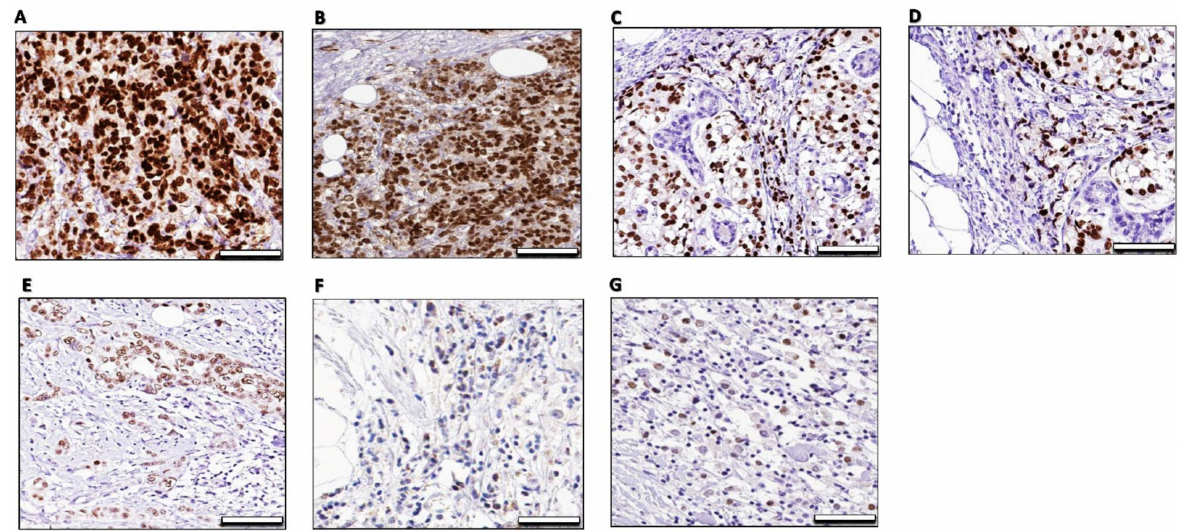
Figure 9. Immunohistochemical analysis of ER- α imunostaining of xenograft tumors the mammary gland fibromuscular stroma consecutive sections in different mice groups. The xenografted tumors were harvested and immunostained with the anti-ER α antibody. ( A )—MCF-7 xenograft: A photomicrograph of a section in the mammary gland of the control group showing a strong ER α -positive nuclear and/or cytoplasmic immunoreaction in the form of a brown color in the cells of the fibromuscular stroma. ( B )—MCF-7 xenograft/DOX: A photomicrograph of a section in the mammary gland of DOX treated group was apparently slightly same intense of ER α nuclear and/or cytoplasmic in the cells of the fibromuscular stroma and morphometric analysis of ER-a-positive cells showed a non-significant increase when compared with the control group. ( C )—MCF-7 xenograft/CQ: A photomicrograph of a section in the mammary gland of CQ treated group was apparently moderately differentiated tubular tumors and displayed moderate of an ER α nuclear intense and less intense of cytoplasmic ER α in the cells of the fibromuscular stroma compared with the control group, ( D )—MCF-7 xenograft/TIC: A photomicrograph of a section in the mammary gland of TIC treated group was apparently moderate differentiated tubular tumors and displayed moderate intense of an ER α nuclear intense and less intense of cytoplasmic ER α in the cells of the fibromuscular stroma compared with the control group. ( E )—MCF-7 xenograft/DOX + CQ: A photomicrograph and displayed less intense of an ER α nuclear and cytoplasmic intense of ER α in the cells of the fibromuscular stroma compared with the control group. ( F )—MCF-7 xenograft/DOX + TIC: A photomicrograph of a section in the mammary gland of DOX/CQ treated group was apparently moderate differentiated tubular tumors and displayed less intense of an ER α nuclear and cytoplasmic intense of ER α in the cells of the fibromuscular stroma compared with the control group. ( G )—MCF-7 xenograft/DOX + CQ + TIC: A photomicrograph of a section in the mammary gland of DOX/CQ/TIC treated group was apparently developed poorly differentiated tumors showing almost slightly loss of ER α intense in the cells of